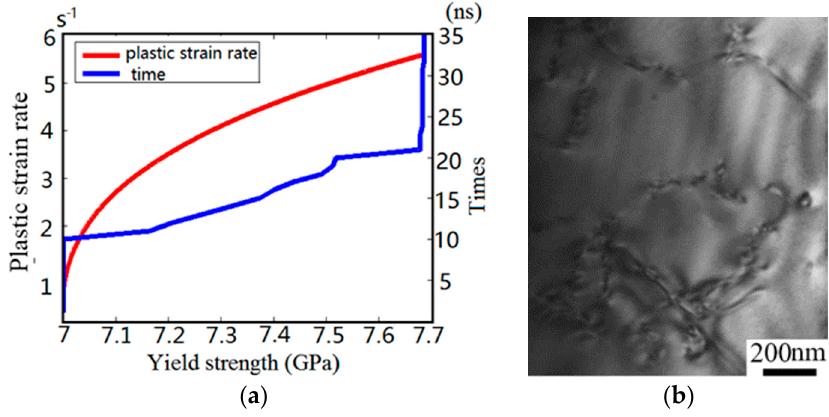
Figure 12. ( a ) The evolution of yield strength during transient irregular cutting process; ( b ) the TEM images obtained from transient loaded silicon crystal [39].